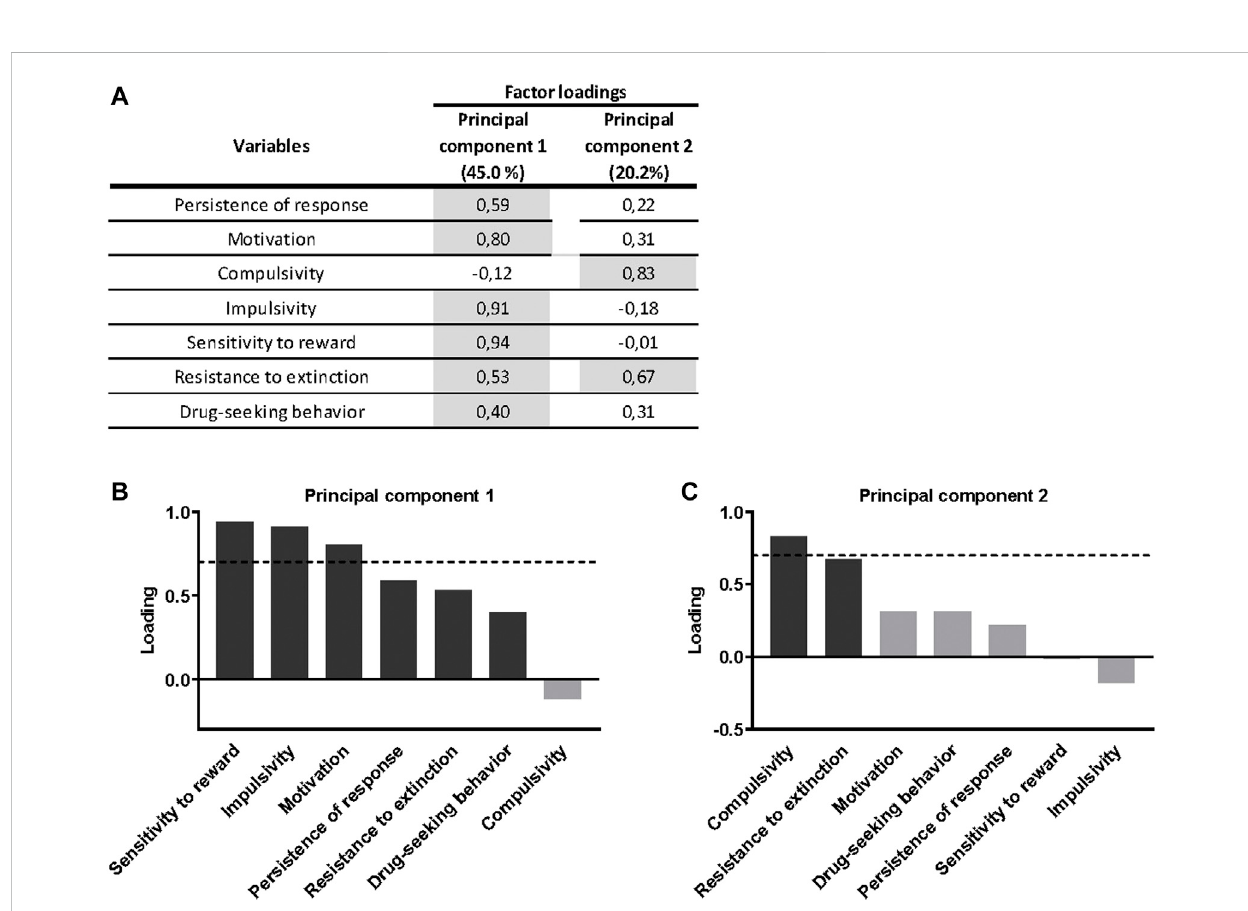
Principal component analysis of cannabinoid addiction through WIN 55,212 – 2 operant self-administration. (A) Factor loadings of the principal component 1 (PC1) and principal component 2 (PC2) in all variables studied. (B – C) Order of factor loading of the different variables in PC1 and PC2. The dashed horizontal line marks loading greater than 0.7, mainly contributing to the component. In regards to the addiction criteria, a dissociation between motivation and persistence of response, mainly contributing to PC1, and compulsivity, mainly contributing to PC2, can be observed. Regarding parametersrelatedtocraving,drug-seekingbehaviorweightedmoreinthePC1,whileresistancetoextinctionweightedmoreinthePC2,eventhoughits in fl uence is also present in the PC1. For the phenotypic traits, both weighted more in the